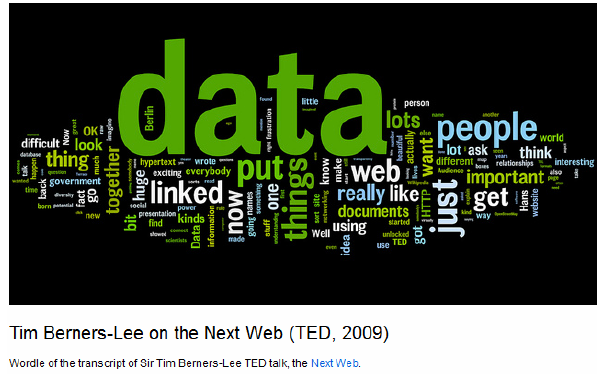
Figure 3 . Participant Wordle related to a particular PLENK